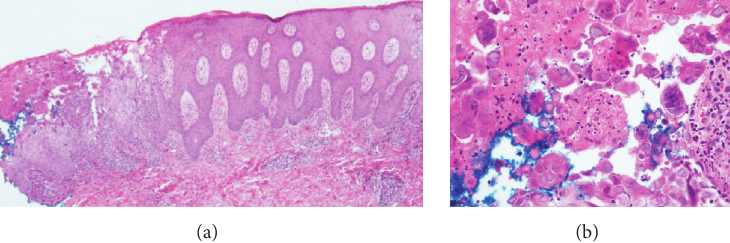
Figure 2: Psoriasis herpeticum. Punch biopsy specimen of the left leg demonstrating (a) psoriasiform acanthosis, epidermal necrosis, and acantholysis with (b) multinucleate keratinocytes with margination of chromatin and nuclear molding (hematoxylin-eosin stain; original magnification: (a) × 40; (b) ×